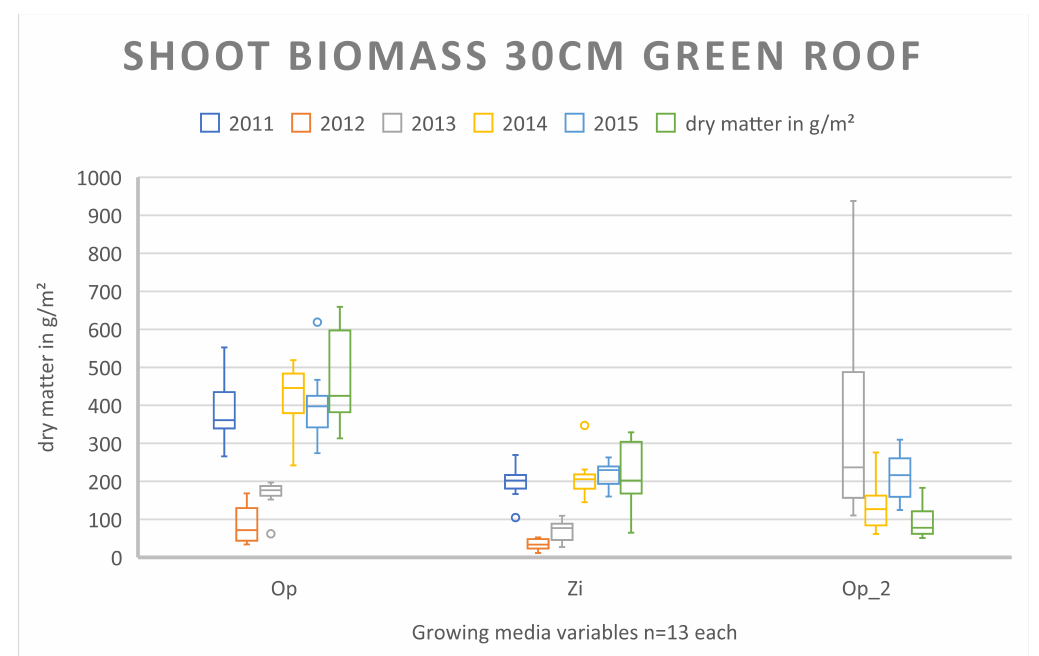
Figure 7. Aboveground annual harvested phytomass on the 30-cm boxes. Each of the three test plots represent 13 replicates at each date. The Op and Zi boxes are on building 2, and Op_2 is on building 3. All data refer to dry matter.